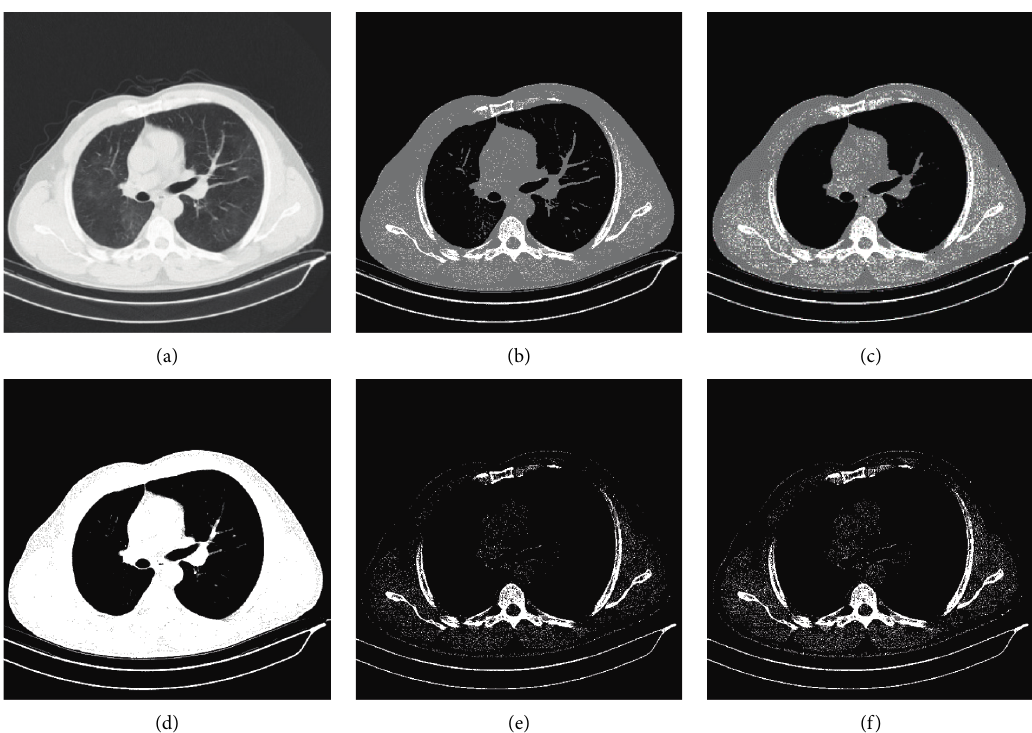
Figure 12: The comparison outcomes, (a) Original CT image-5; (b-d) Segmentation result of threshold level 2,3,4 respectively of proposed approach, (e) Segmentation results obtained by Tao [21], and (f) Segmentation results obtained by Tang